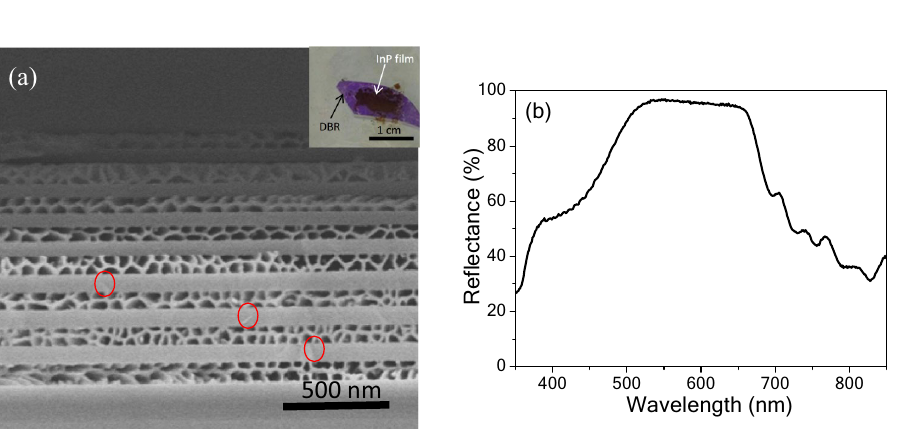
Figure 3. ( a ) Cross-sectional SEM image of MP-GaN DBR (The insert is the photograph of the nanoporous InP membrane transferred to an MP-GaN DBR), and ( b ) reflectance spectra of the bottom MP-GaN